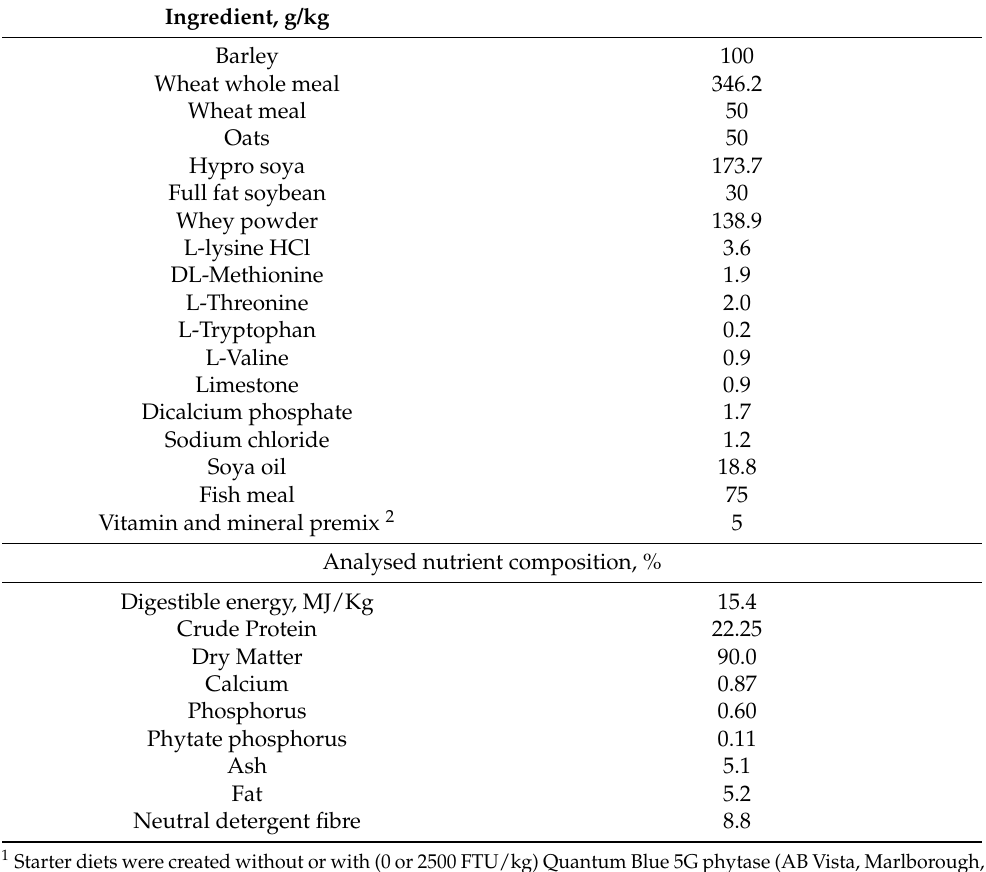
Table 1. Ingredient and nutrient composition of starter diets (as is) 1